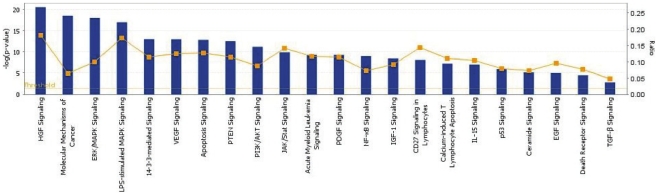
Ingenuity software analysis report of proteomics data arranged by signaling pathways in order of statistical significance.A subset of total ranked pathways is shown here.